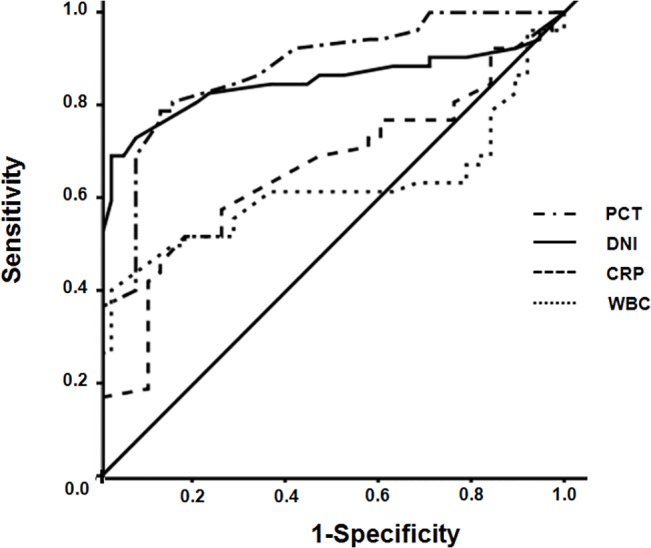
The receiver operating characteristic curves for white blood cells, delta neutrophil index, C-reactive protein, and procalcitonin with respect to the prediction of AGPN.AGPN, acute graft pyelonephritis.